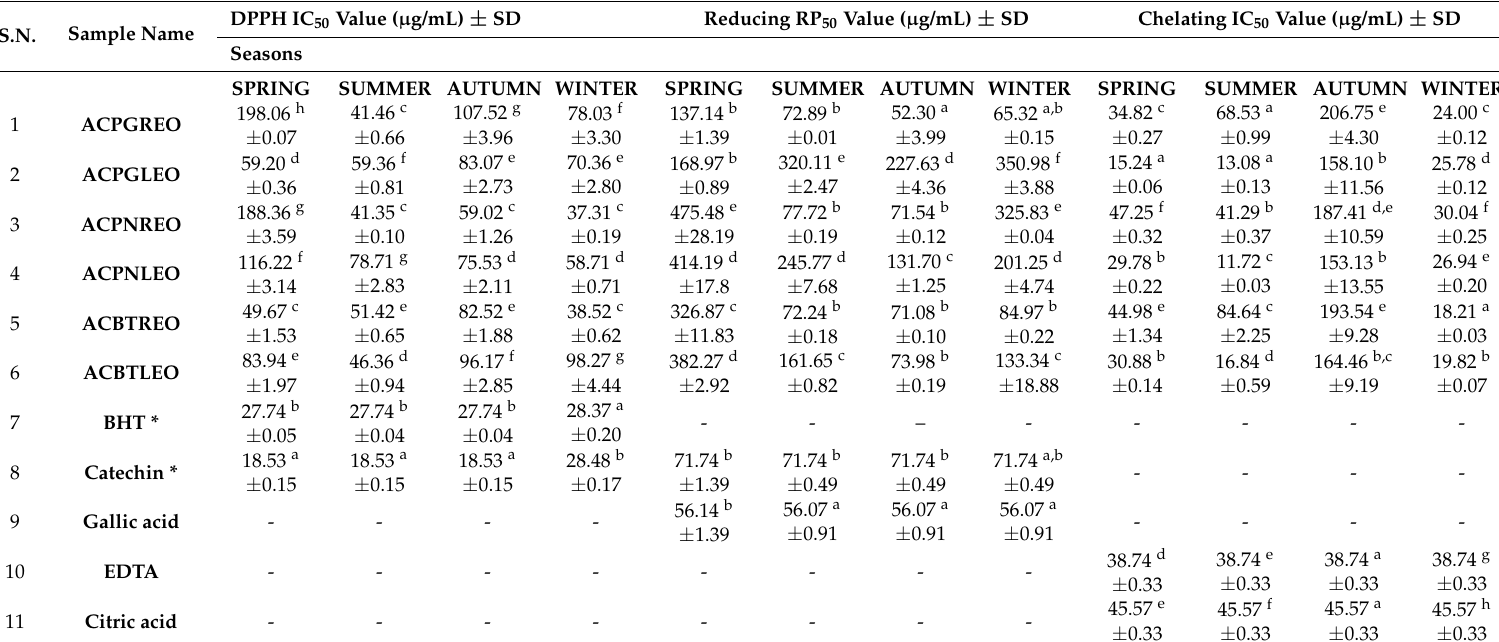
Table 5. Antioxidant activity in terms of IC 50 values for leaves and rhizome essential oils.